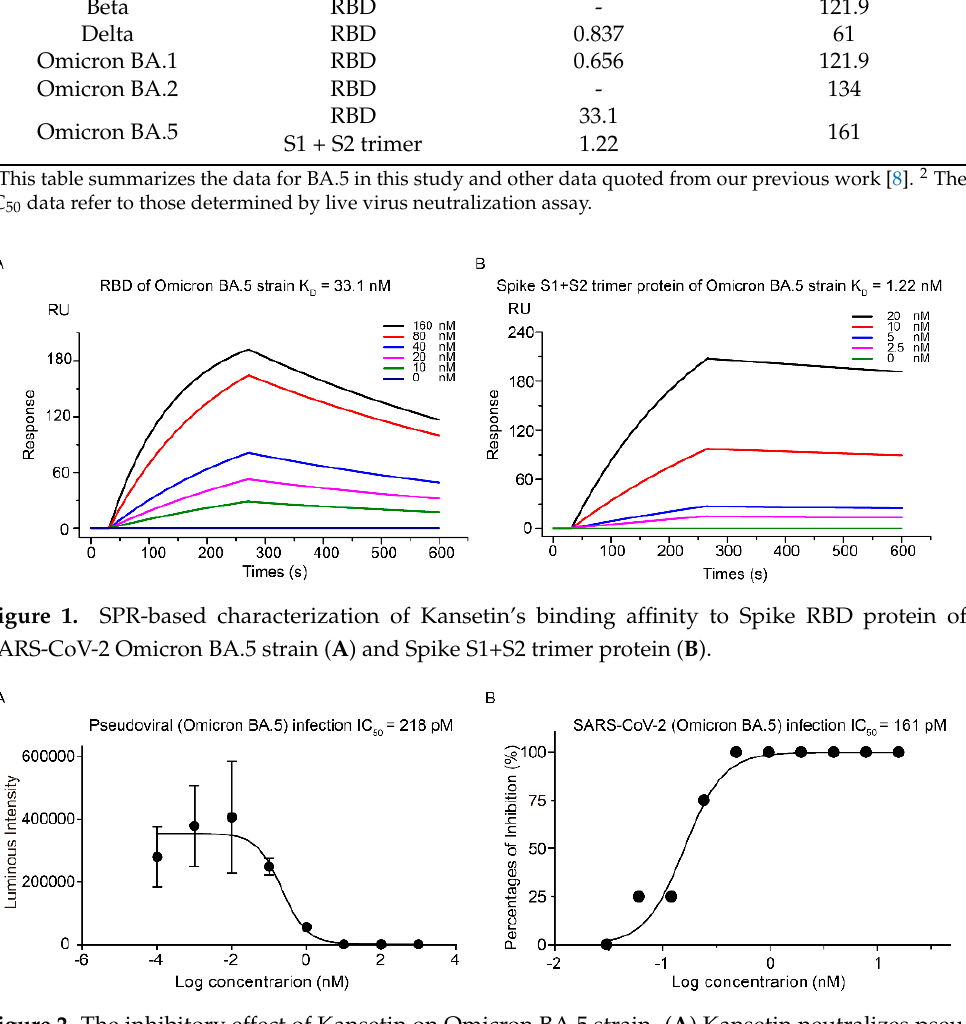
Table 1. Summarization of data between different SARS-CoV-2 strains 1 .